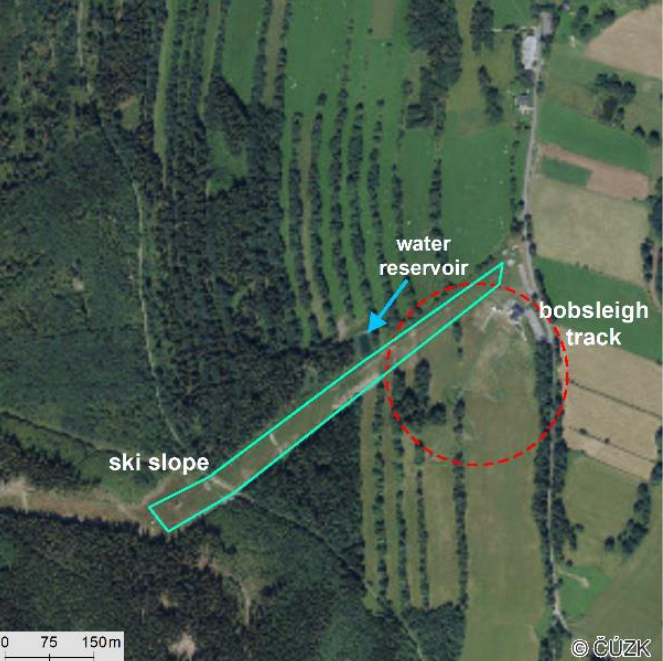
Figure 15. Vrbno pod Pradědem (the Jeseníky Mts) with a water reservoir for snowmaking for the ski slope and a bobsleigh track placed across an array of lynchets [data source: Orthophoto of the CR, ČÚZK, Praha, Czech Republic; processed in ArcGIS, ESRI, Redlands, CA, USA].